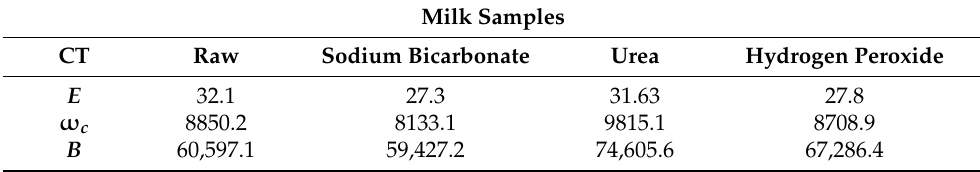
Table 2. Average of the